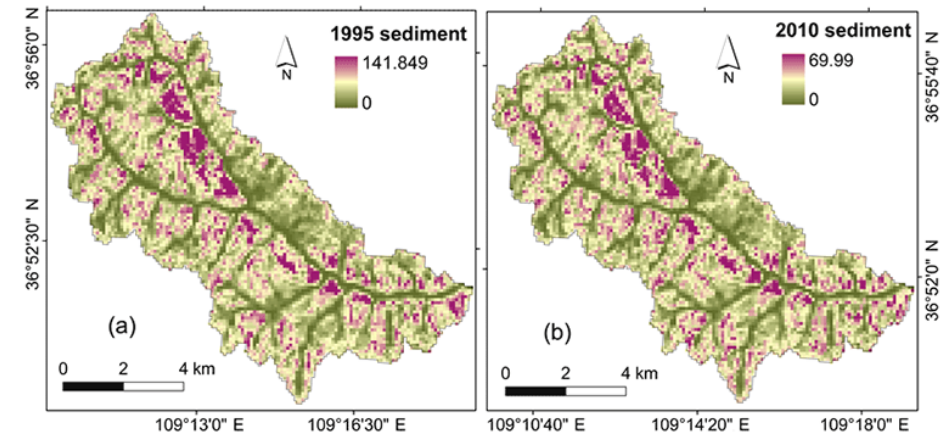
Figure 10. Spatial distribution of the sediment yield modulus (Mgha − 1 ) of the Majiagou River watershed: (a) 1995; (b) 2010.